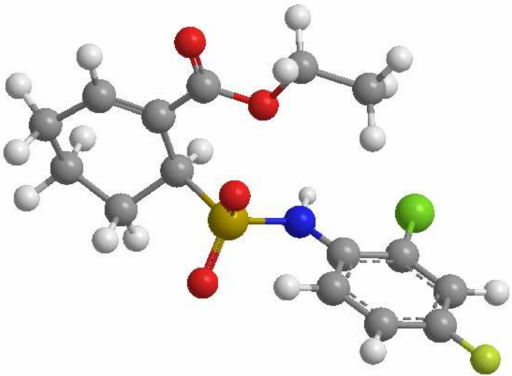
Figure 1. Resatorvid 3D molecular structures: (ChemDraw TM Ver. 16.0; Cambridge Soft, Cambridge, MA,